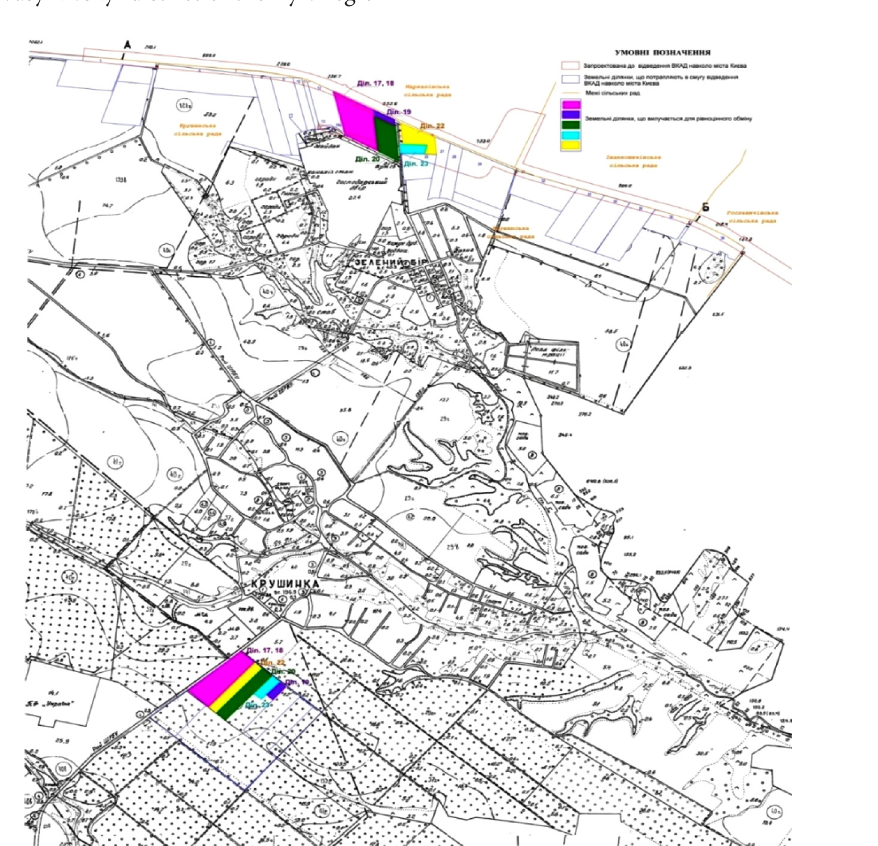
Figure 4. Determination of land plots for peer exchange within Krushinka village of Vasilkovsky district of the Kyiv